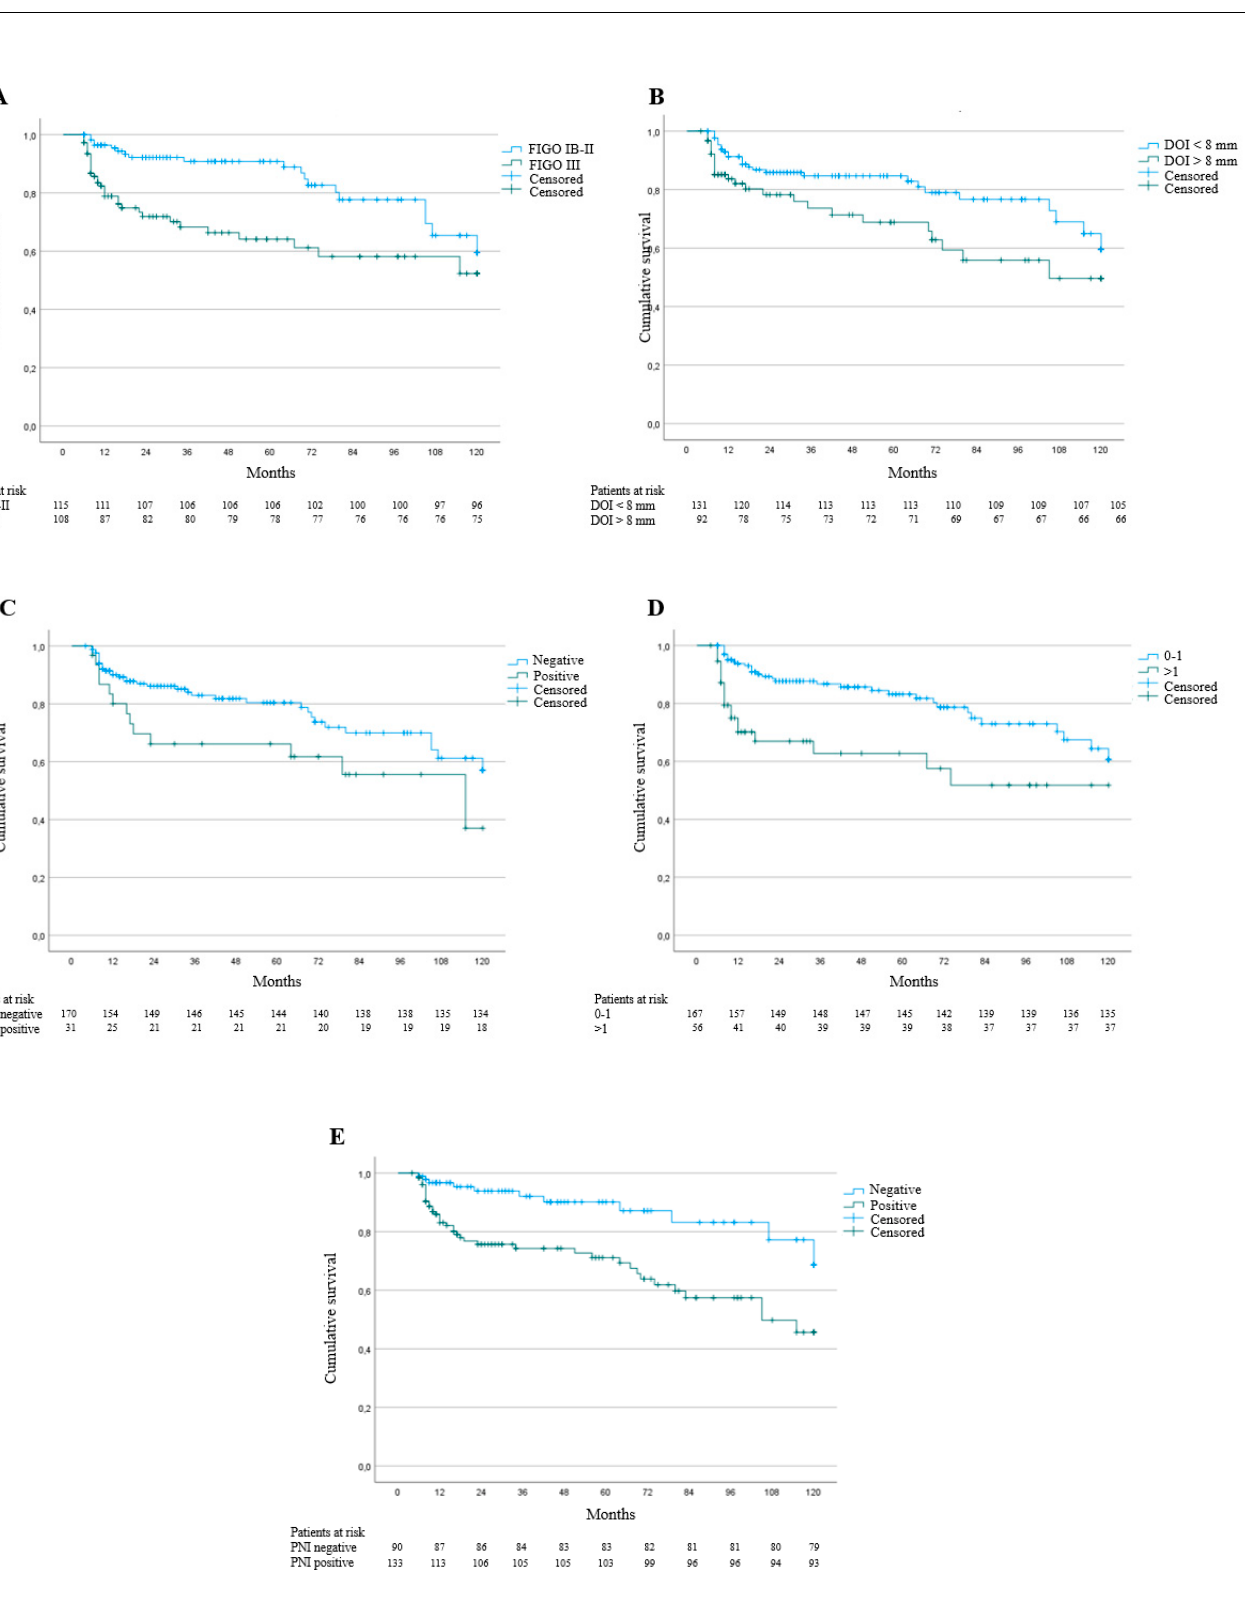
Figure 1. Kaplan–Meier curves for cancer-specific survival (CSS) according to FIGO stage ( A ), depth of invasion (DOI) ( B ), surgical margin involvement ( C ), number of positive groin lymph nodes ( D ), and perineural invasion (PNI) ( E ).